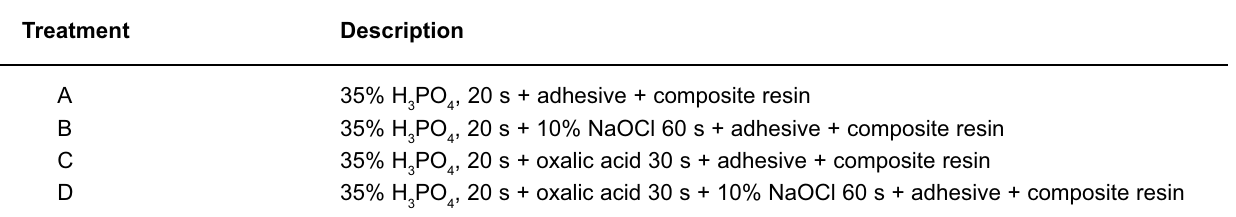
TABLE 2- Microtensile bond strength mean values and standard deviations Treatment